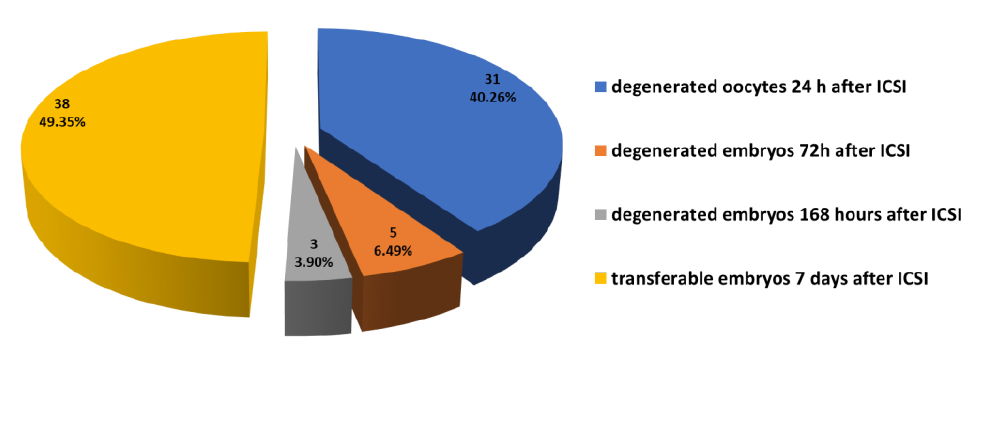
Figure 9 . Results obtained after ICSI in bovine oocytes obtained from slaughtered old